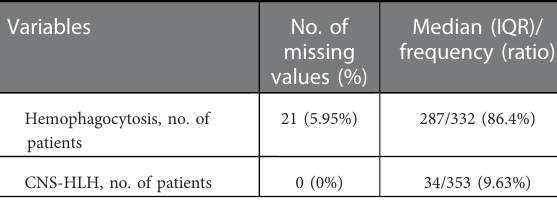
TABLE 1 Demographic and clinical characteristics of 353 HLH patients at the time of